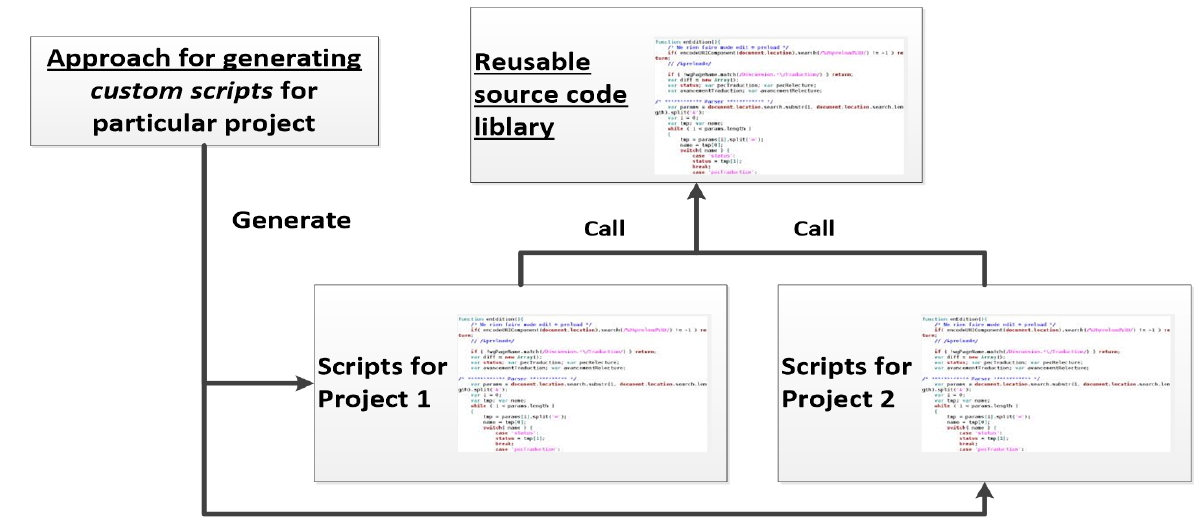
Fig. 2. The main principles of the provided